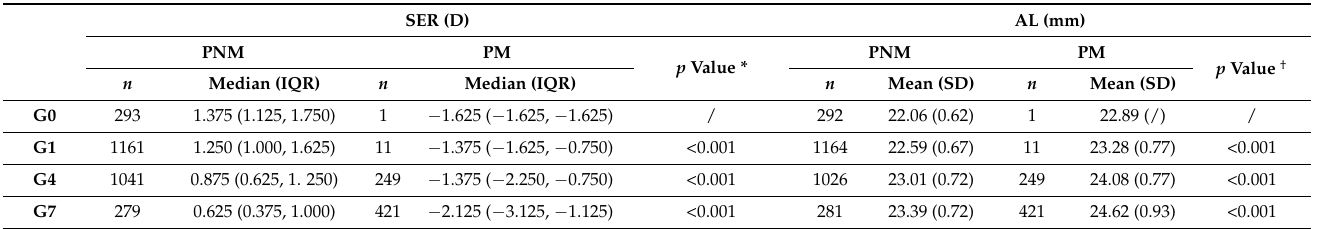
Table 1. Baseline distribution of SER and AL among persistent non-myopia and persistent my- opia groups.